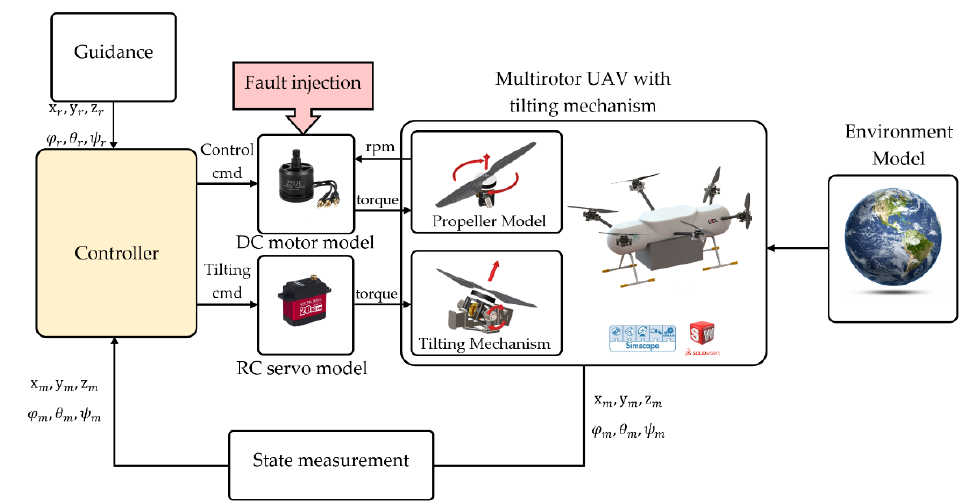
Figure 7. UAV system modeling and simulation block